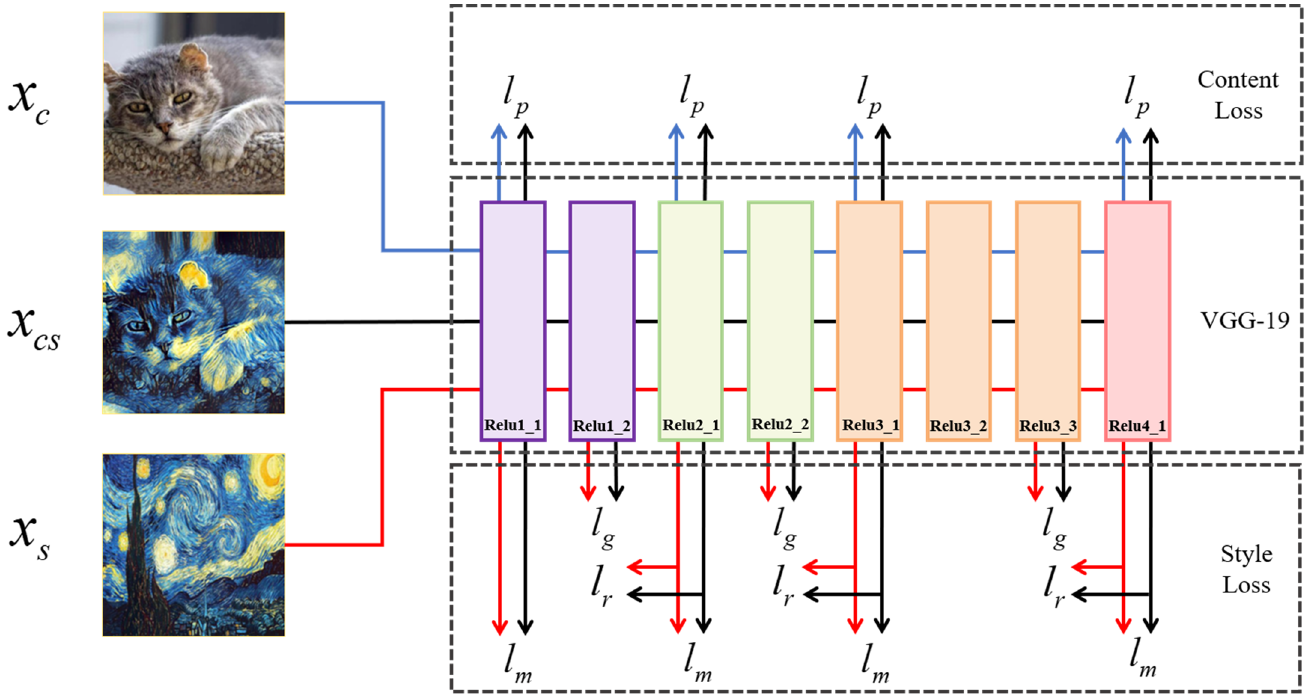
Figure 5. The schematic for loss network.